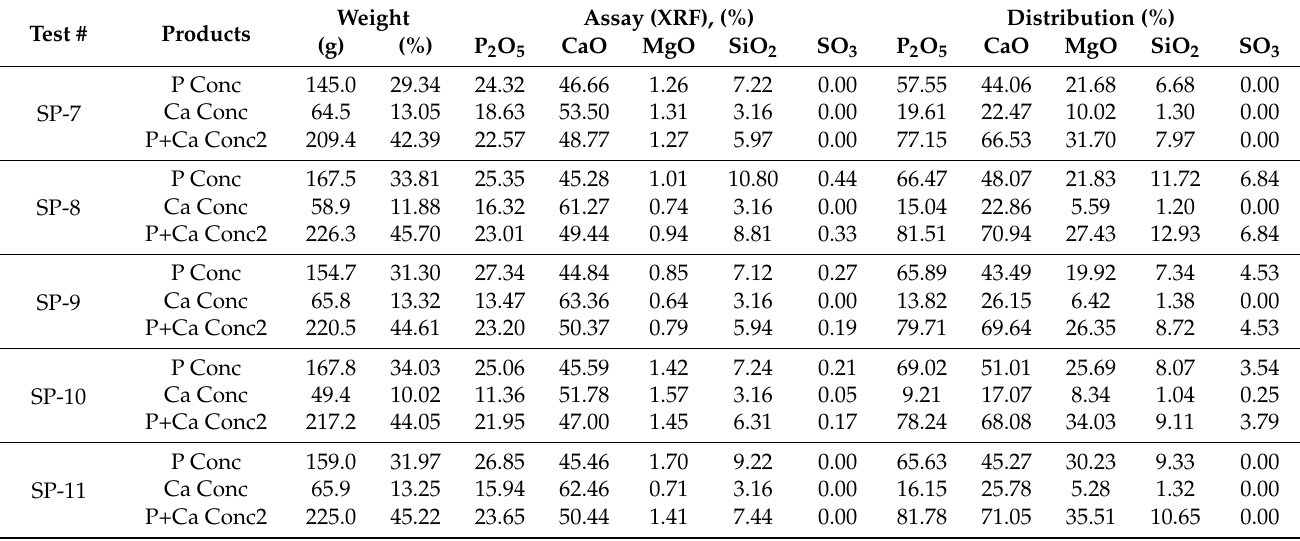
Table 7. The results of carbonate reverse flotation from bulk skarn phosphate flotation